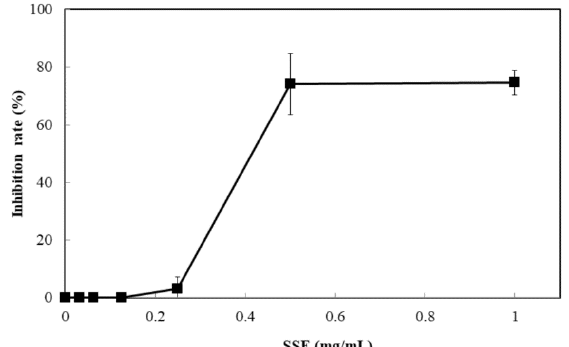
Figure 3. Anticandidal activity analysis of SSE. The liquid culture of C. albicans was introduced into 96-well plate and different concentrations of SSE (0, 0.03125, 0.0625, 0.125, 0.25, 0.5 and 1 mg/mL) were added. The 96-well plate treated with SSE was cultivated at 37 °C for 24 h and determined by a plate reader at 600 nm. Results are mean ± S.D. ( n = 3).